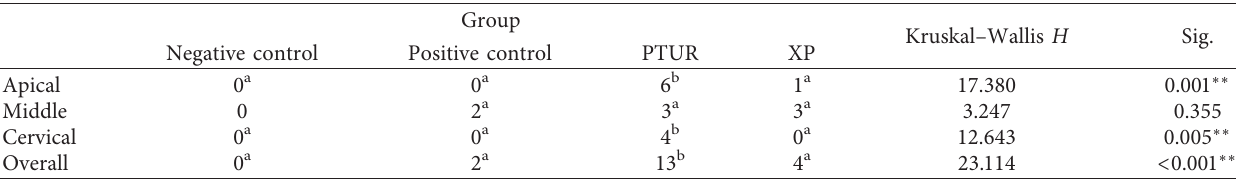
Figure 2: Presence or absence of defects among the groups. ∗ PTUR shows significantly greater presence of defects (Kruskal–Wallis H � 23.114, df � 3, p < 0 . 001). Table 3: Distribution of defects among teeth ∗